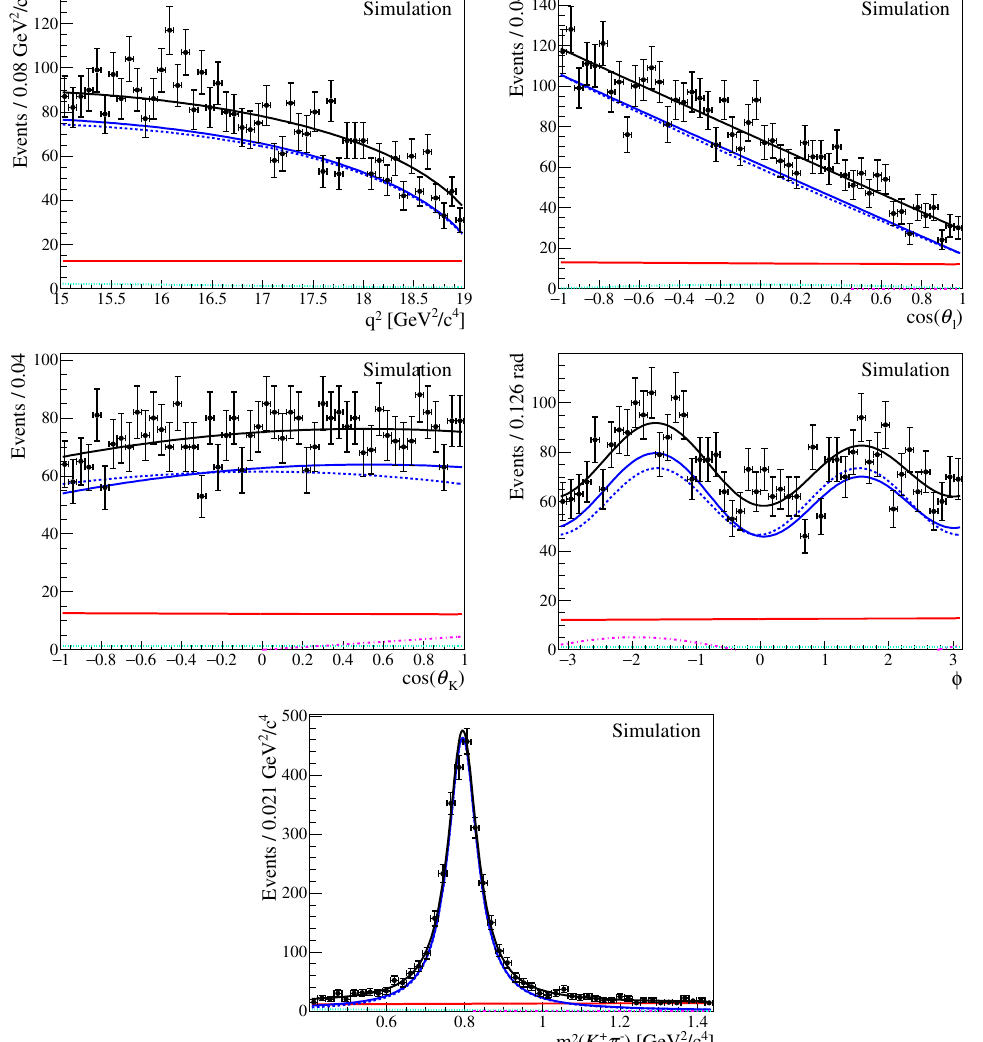
Figure 8. Results from the (cid:12)t of a single pseudoexperiment varying the Wilson coe(cid:14)cients Re( C 9 ) and Re( C 10 ). Simulated events are overlaid with projections of the (cid:12)tted PDF on q 2 , the three decay angles cos (cid:18) l , cos (cid:18) K and (cid:30) and m 2 in the q 2 range 15 : 0 < q 2 < 19 : 0 GeV 2 =c 4 . The sim- K(cid:25) ulated events and projections are shown for the signal region (cid:6) 50 MeV =c 2 around the B 0 mass to enhance the signal fraction. The black solid line denotes the full PDF, the blue solid line the signal component. The blue dashed line gives the P-wave and the teal dotted line the S-wave part. The magenta dash-dotted line (cid:12)nally gives the P-wave/S-wave interference and the red line the back- ground contribution. We note again that the q 2 distribution in the high q 2 region is only shown for illustration, as it is not used in the direct (cid:12)t